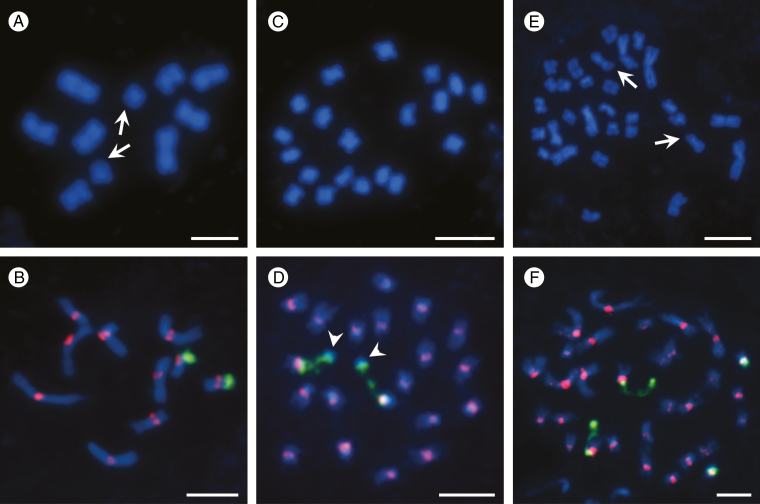
Somatic metaphase (A, C, E) and prometaphase (B, D, F) chromosomes of B. distachyon Bd21 (A, B), B. stacei ABR114 (C, D) and B. hybridum ABR113 (E, F). Chromosomes in (A, C, E) were stained with DAPI (blue) only, arrows in (A, E) show DAPI-negative secondary constriction/satellite regions. Chromosomes in (B, D, F) were subjected to FISH using centromeric (red) and 25S rDNA (green) probes. Arrowheads in (D) show the specific organization of the satellites in B. stacei. Scale bars = 5 µm.